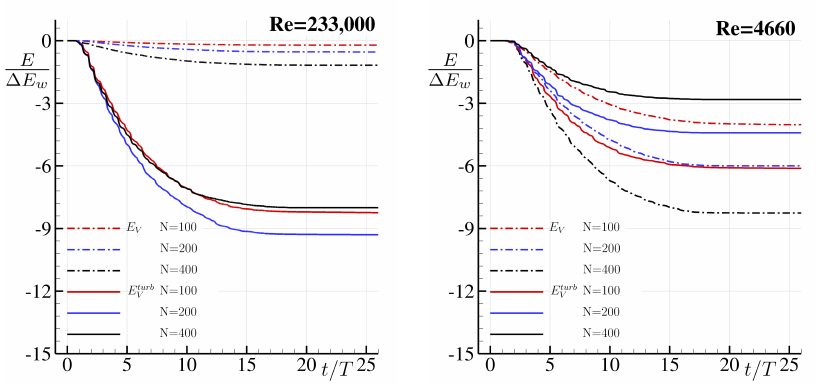
Figure 9. Energy dissipation due to the real and turbulent viscosity for different spatial resolutions. ( Left ) water test-case. ( Right ) oil test-case.